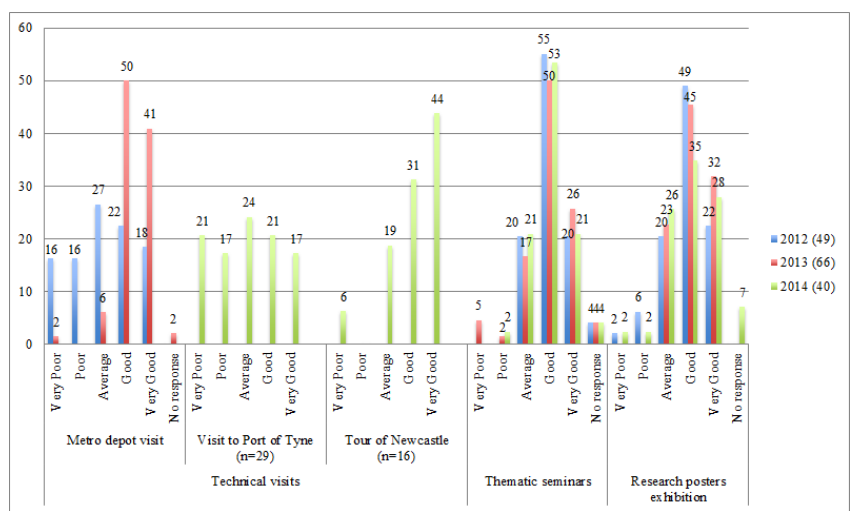
Figure 7. Ratings for selected activities of Week 3 [%].